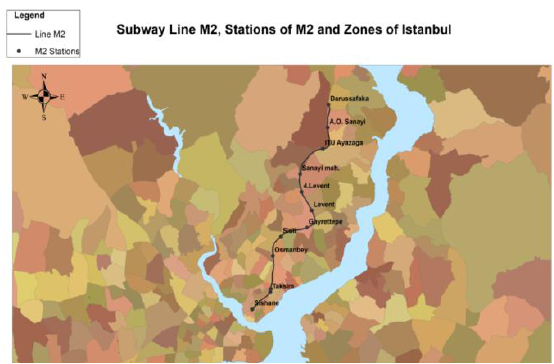
Fig. 4. Subway line M2, stations of line M2 and the zones of Istanbul.